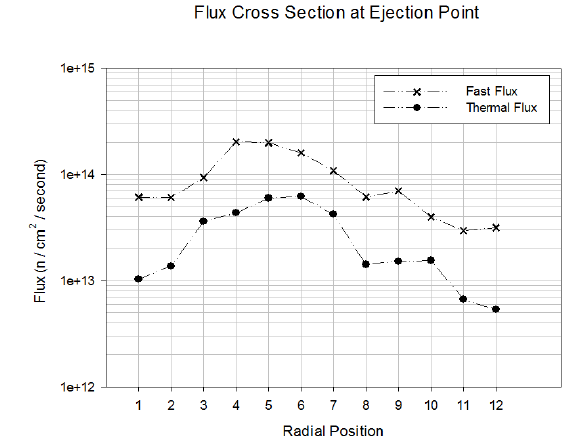
Figure 15. Flux profile cross section at ejection point after 100 s.